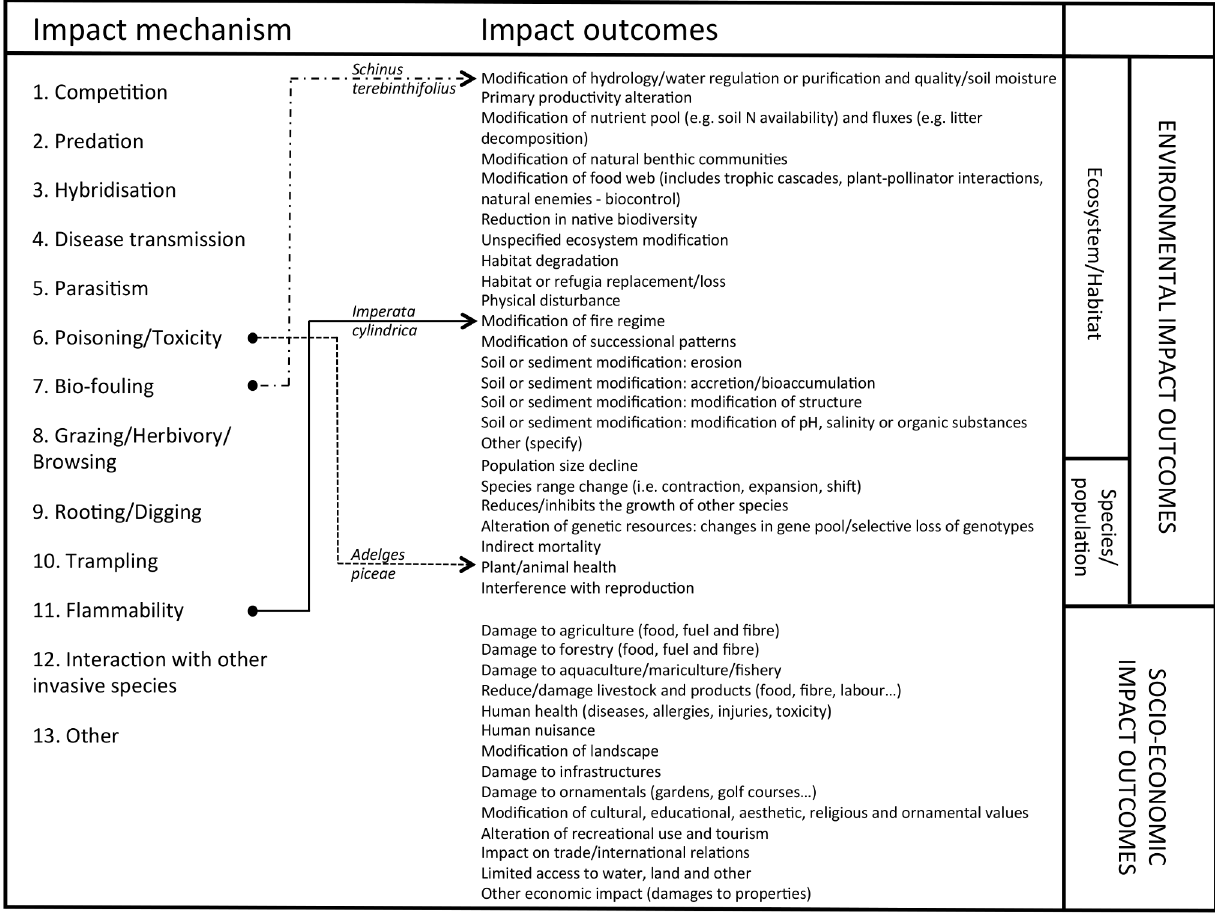
Figure 1. Impact scheme of the Global Invasive Species Database, implemented by the IUCN Species Survival Commission (SSC) Invasive Species Specialist Group. The GISD stores detailed information on more than 800 invasive alien species, including on the impacts they cause. The GISD has recently been redesigned, and all information has been re-classified in order to improve the searching functionalities of the database. The schema developed for the revised GISD has allowed all species stored in the database to be coded in respect of the direct mechanisms by which their impacts occur (e.g., predation), and by the outcomes of those impact mechanisms on the environment or on human activities. For example, the grass Imperata cylindrica (Poales: Poaceae) almost doubles litter biomass in invaded locations, which increases potential fuel for fires (impact mechanism coded as flammability, and impact outcome as modification of fire regime). The plant Schinus terebinthifolius (Sapindales: Anacardiaceae) is a bio-fouling agent, forming dense thickets in gullies and river bottoms, with the ultimate effect of changing the hydrology of river streams of invaded freshwater bodies (mechanism coded as bio-fouling, and impact outcome described as modification of hydrology). The insect Adelges piceae (Hemiptera: Adelgidae) releases a toxin causing stress to trees, which eventually die. The impact outcome of A. piceae is described in GISD as damage to forestry, with its mechanism of impact coded as poisoning/toxicity, but it can also be coded as having an environmental impact on plant/animal health, as it has been here. In the table, mechanisms and outcomes are reported in two separate columns, and the three examples of the connections between mechanisms and outcomes are shown. Impact outcomes in the GISD database can be environmental or socio-economic, but our categorisation scheme of species in terms of the magnitudes of their impacts (Figure 2; Table 1) concerns only the